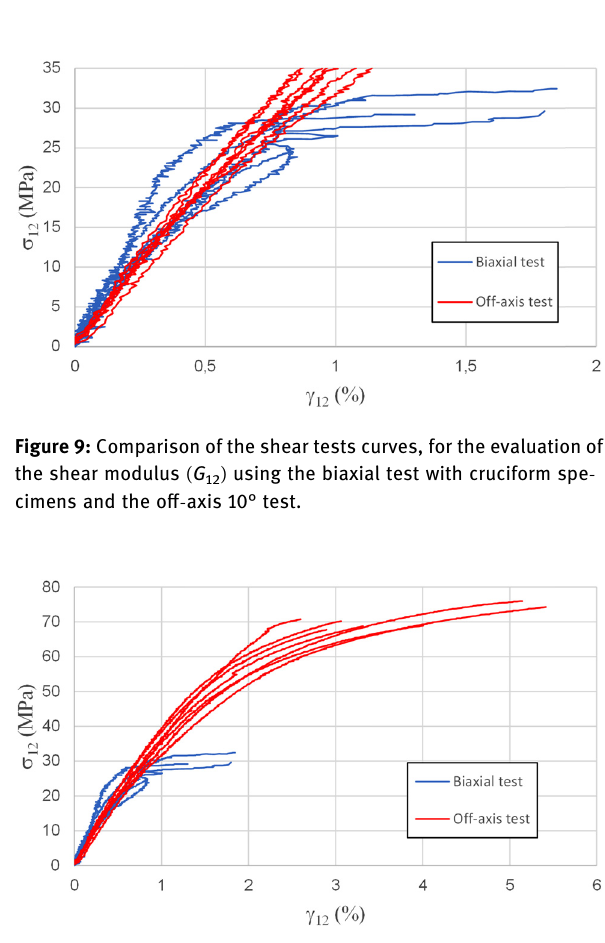
Figure 10: Comparison of the shear tests curves, for the evaluation of the shear strength ( σ 12_max ) for both test con fi gurations.